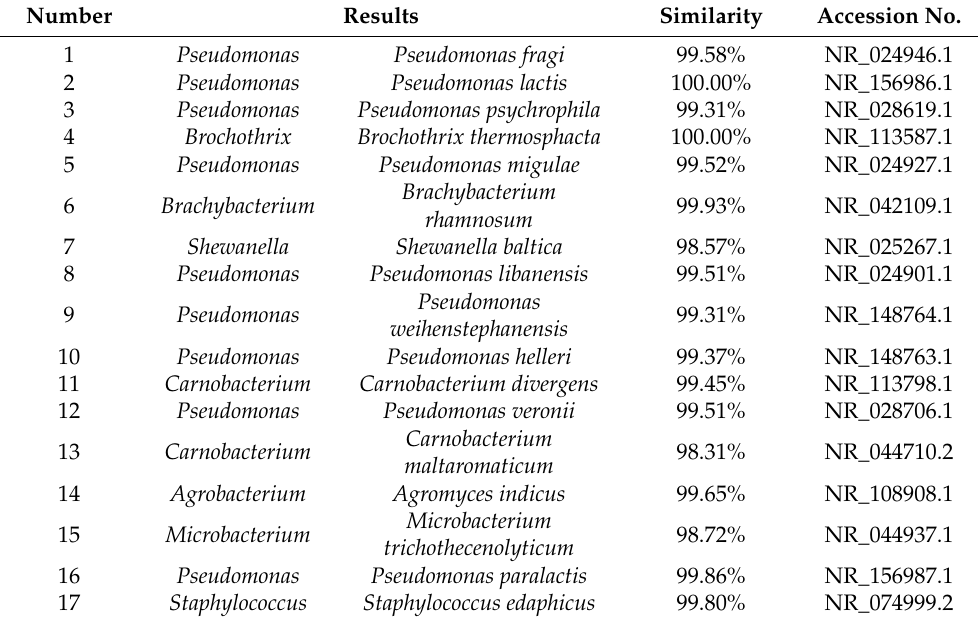
Table 3. The result of the sequence alignments of gene